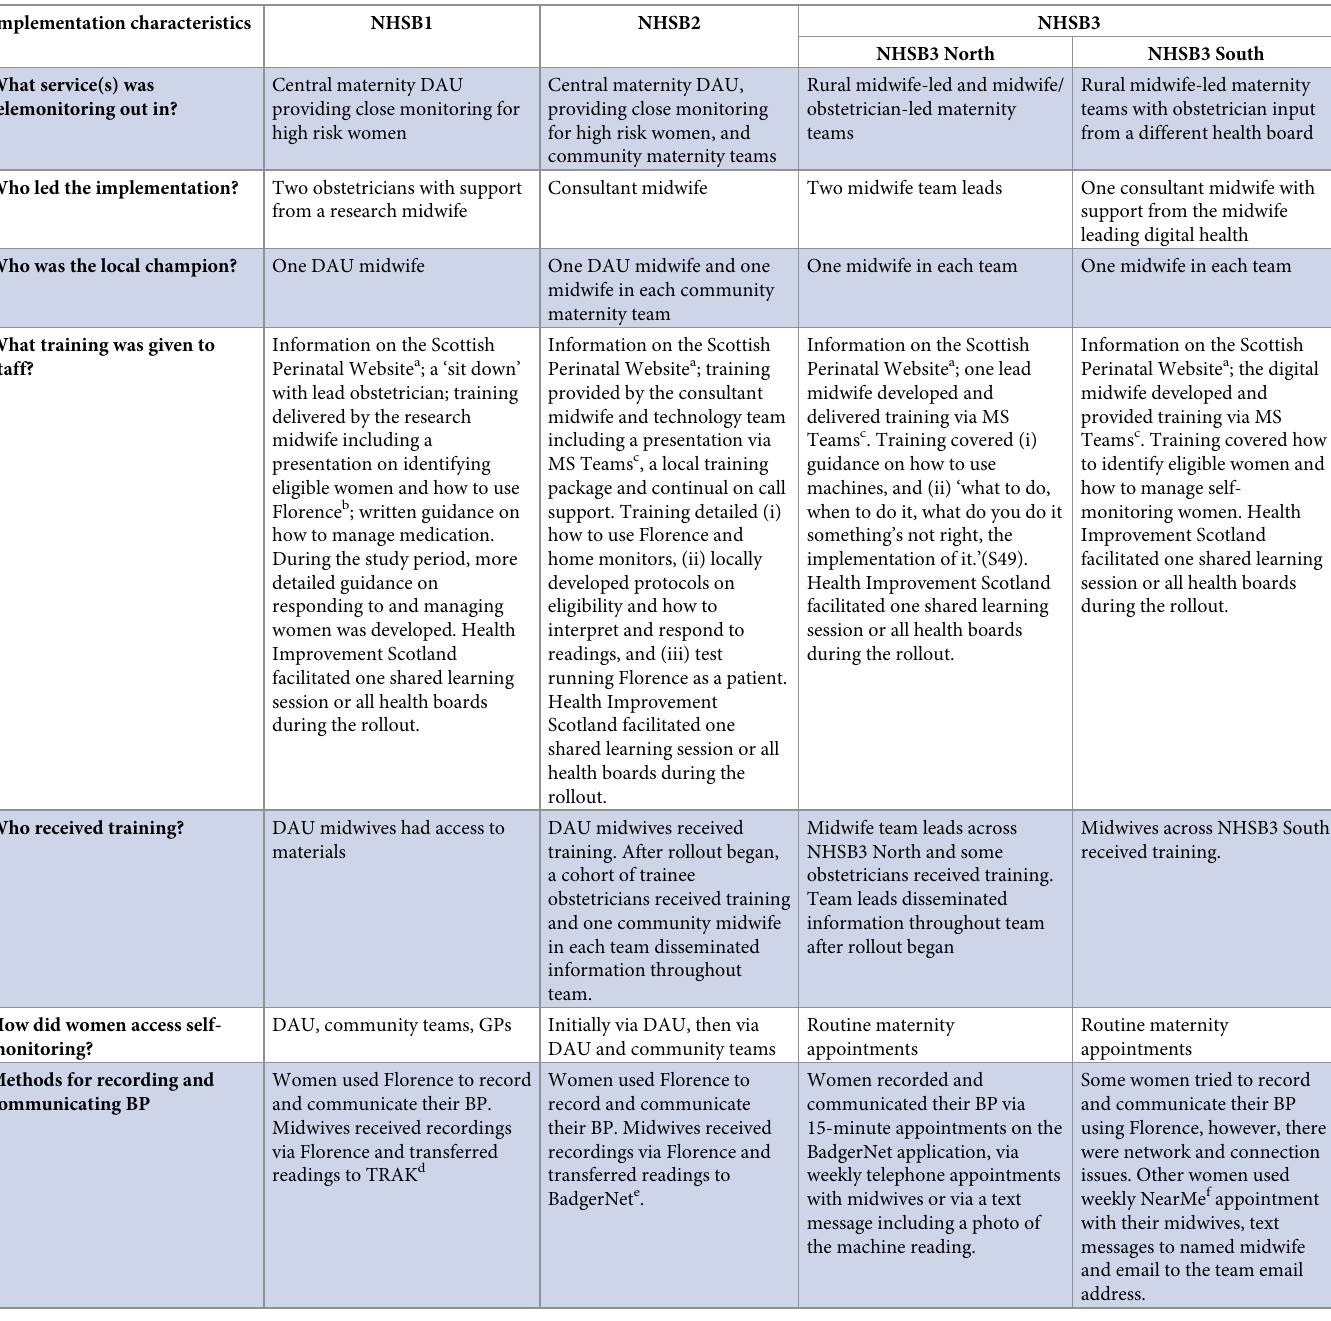
Table 3. Table describing implementation in each NHS health board. Implementation